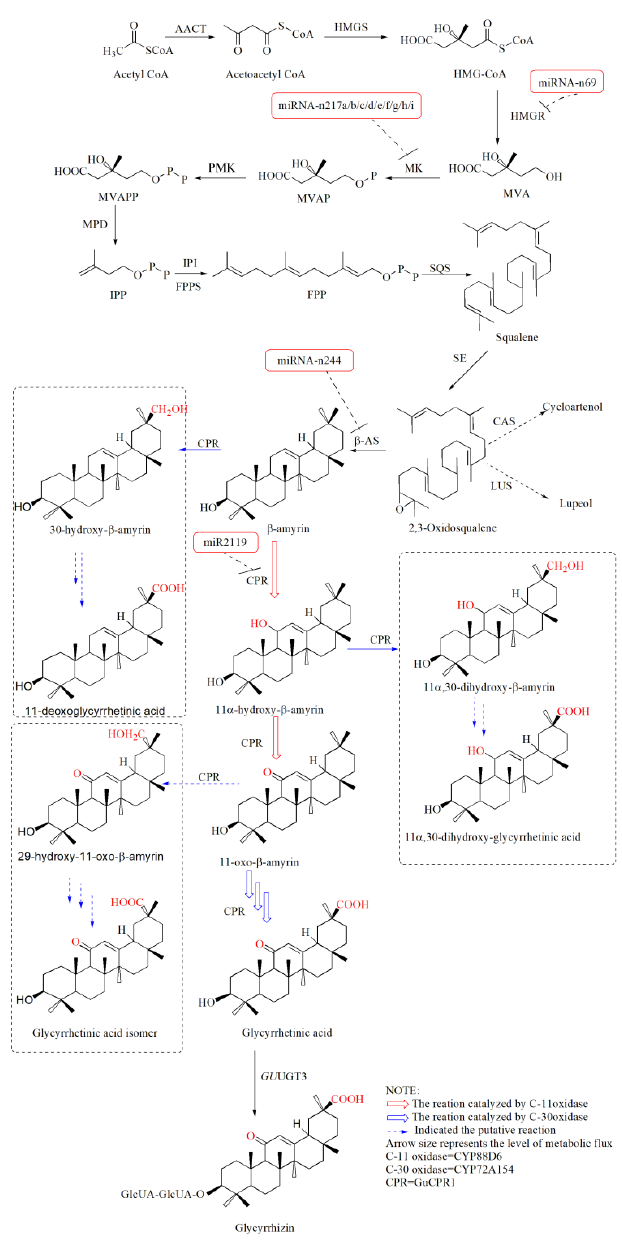
Figure 1. Proposed GA biosynthetic pathway in G. uralensis . Red, blue arrows indicate reactions catalyzed by C-11, C-30 oxidase, respectively. Dotted arrows indicate the proposed reactions. Structural genes potentially targeted by the identified G. uralensis miRNAs are represented by red rectangular boxes. The dotted line represents uncertain action in the pathway. AACT: acetyl-CoA C-acetyltransferase; HMGS: 3-hydroxy-3-methylglutaryl coenzyme A synthase; HMGR: 3-hydroxy-3- methylglutaryl-coenzyme A reductase; MK: mevalonate kinase; PMK: phosphomevalonate kinase;